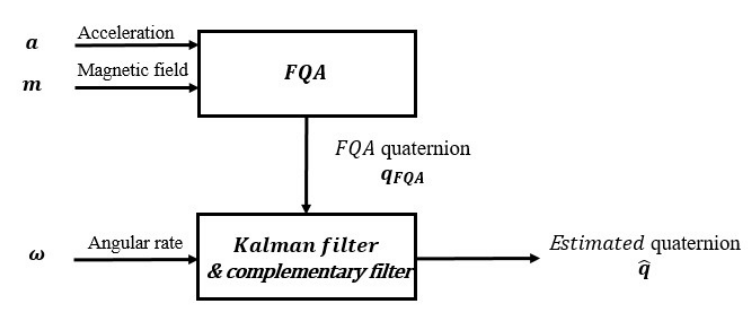
Figure 1. The principle block diagram of the designed